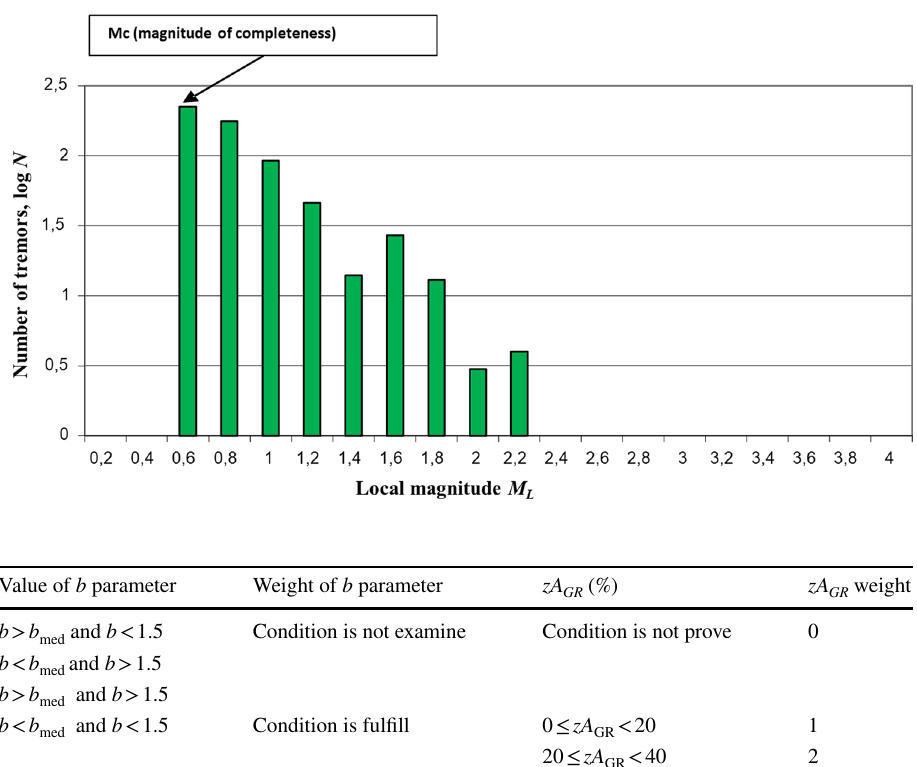
Fig. 1 Example magnitude threshold value determination